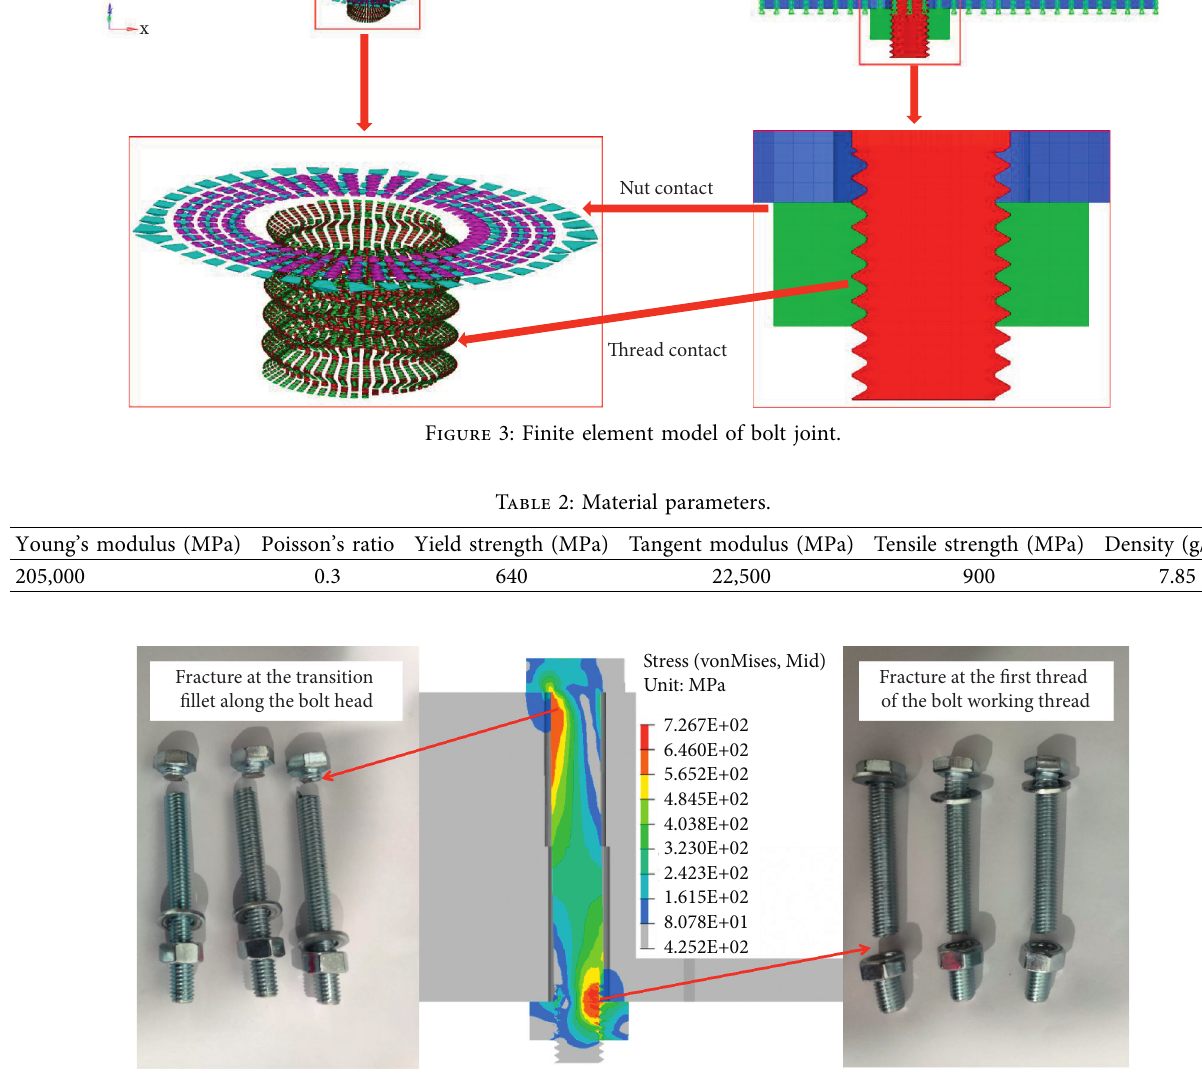
Figure 4: Comparison of fractured bolts and their simulation stress.